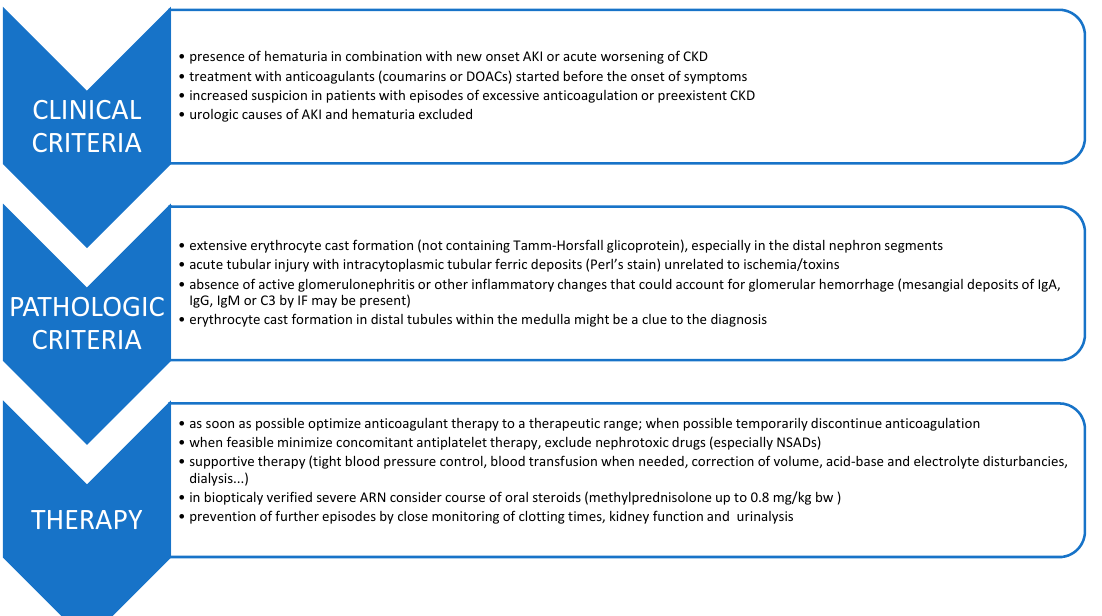
Figure 3. Proposed clinico-pathologic flow-chart to approach anticoagulant-related nephropathy. Abbreviations: ARN- anticoagulant related nephropathy, CKD-chronic kidney disease, AKI-acute kidney injury, DOACs-direct oral anticoagulants, IF-immunofluorescence, Ig-immunoglobulin, C3-complement component C3.